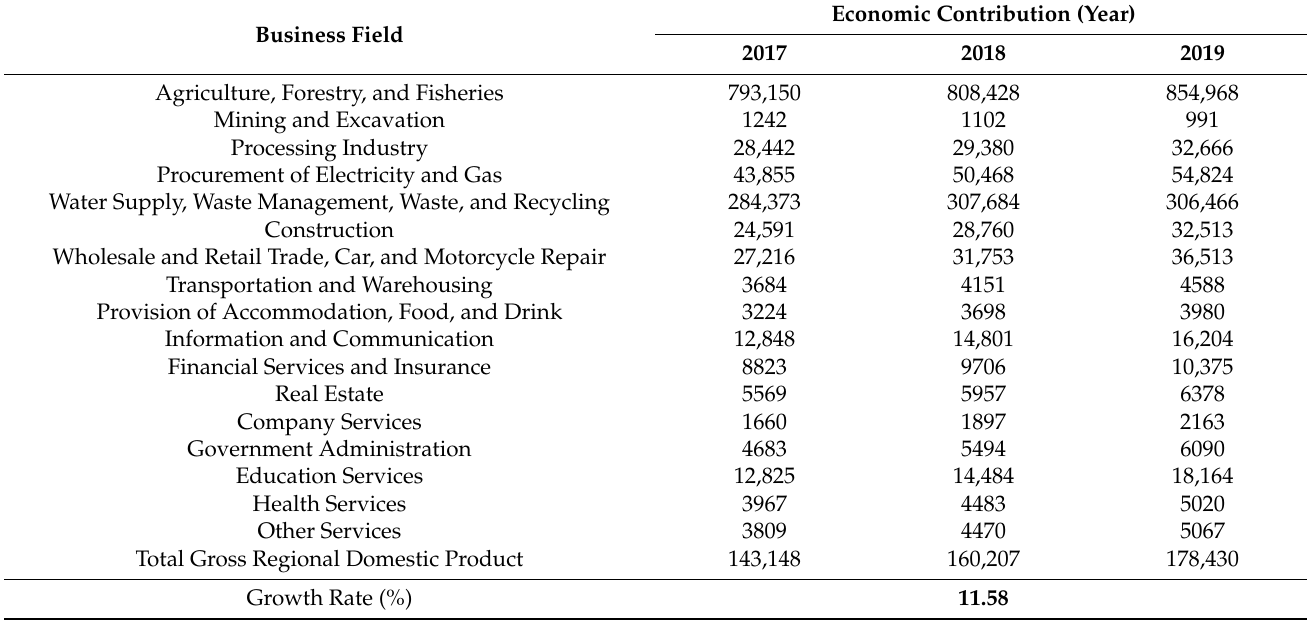
Table 1. Gross Regional Domestic Product of Makassar City in